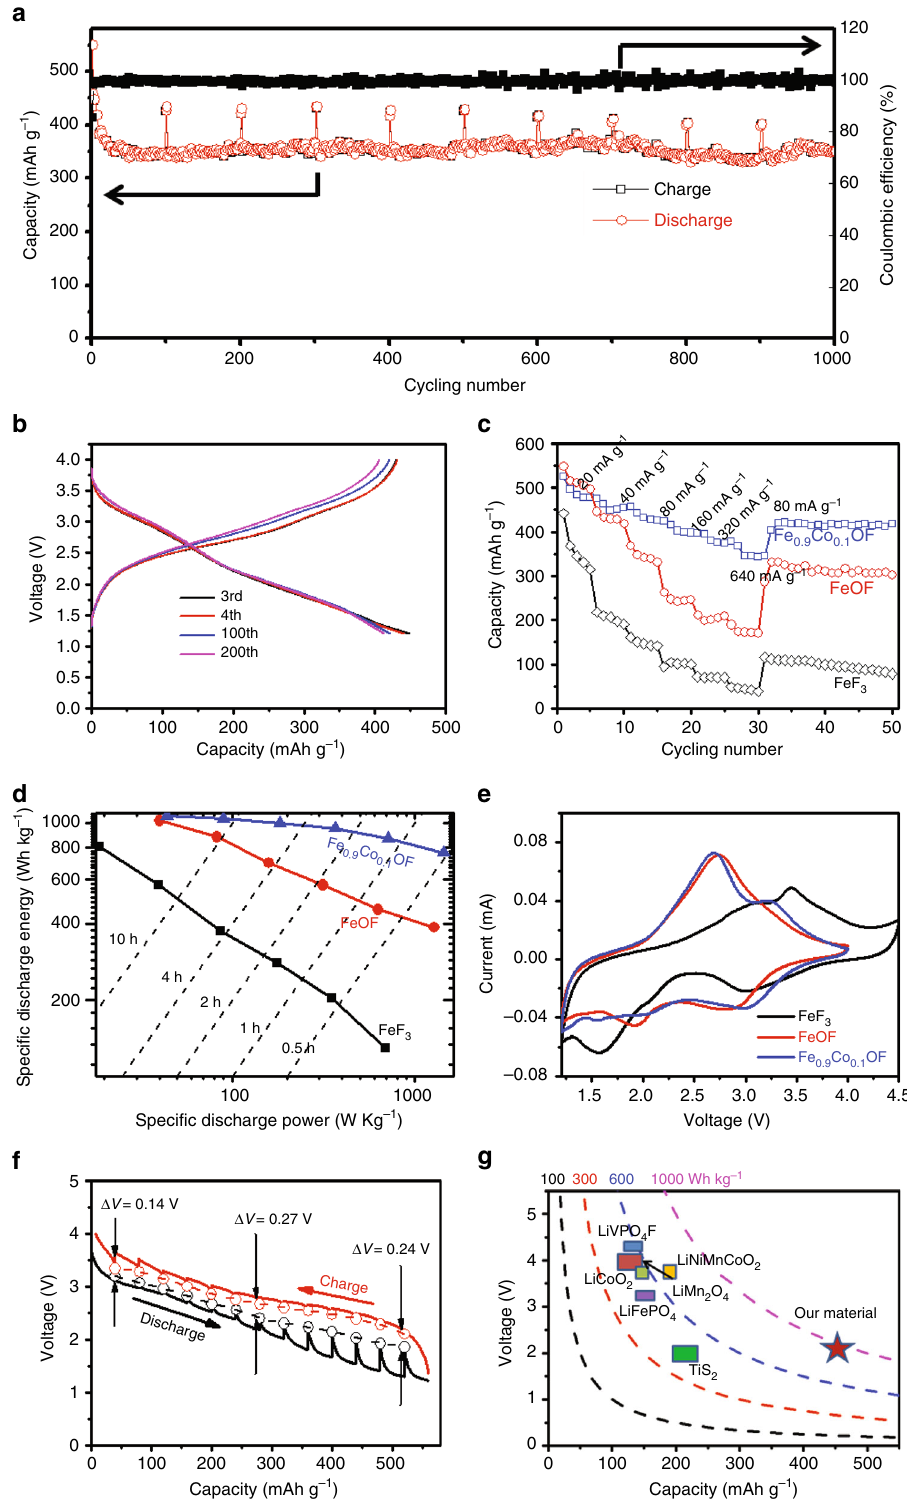
Fig. 2 Electrochemical performance of the Fe 0.9 Co 0.1 OF cathode. a Cycling performance for Fe 0.9 Co 0.1 OF cathode with a current of 500 mA g − 1 , every 100 cycles, the current changed to 70 mA g − 1 and cycled two cycles; b representative discharge/charge curves for Fe 0.9 Co 0.1 OF at a current of 70 mA g − 1 in the potential range of 1.2 – 4.0 V; c rate capability for Fe 0.9 Co 0.1 OF, FeOF, and FeF 3 cathode materials, respectively; d the Ragone plot of FeF 3 , FeOF, and Fe 0.9 Co 0.1 OF (based on active mass); e CV pro fi les for the three materials (FeF 3 , FeOF, and Fe 0.9 Co 0.1 OF) with a scanning rate of 0.1 mV s − 1 . f Galvanostatic intermittent titration technique (GITT) measurement of Fe 0.9 Co 0.1 OF (40 mA g − 1 for 1 h followed by a 20 h rest); g capacity, voltage, and energy density of Fe 0.9 Co 0.1 OF (discharge energy density is calculated based on discharge current of 40 mA g − 1 ) as compared with the intercalation